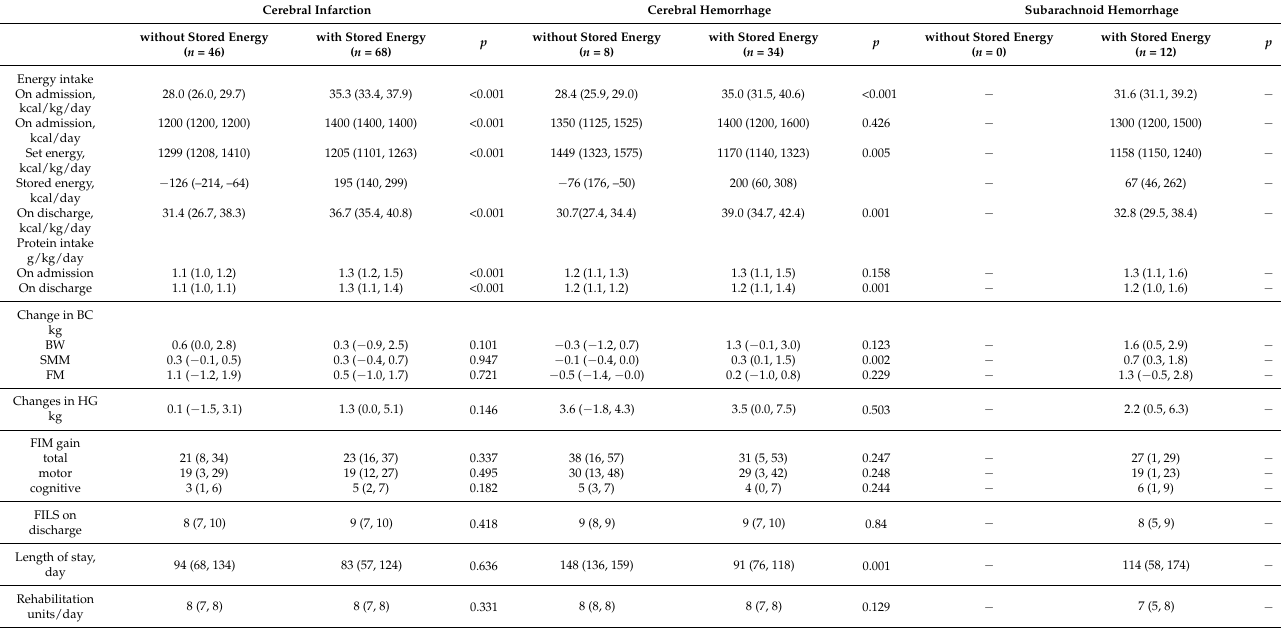
Table 2. Univariate analyses for outcomes between groups of patients with and without stored energy intake by stroke type. CerebralInfarction CerebralHemorrhage SubarachnoidHemorrhage